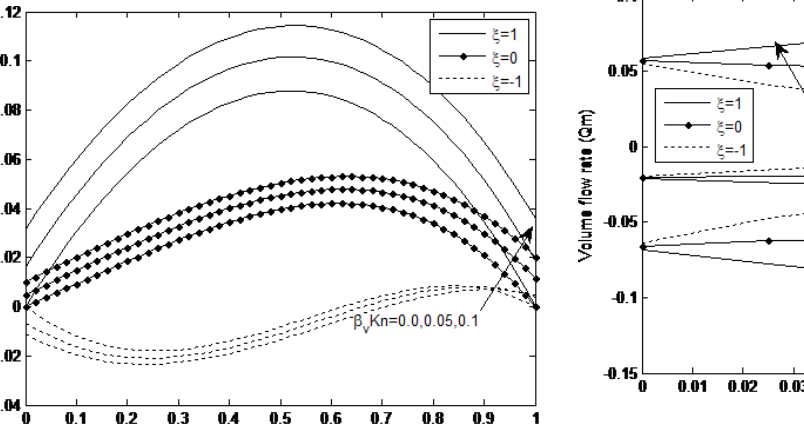
Fig. 7: Volume flow rate versus β v Kn for different of